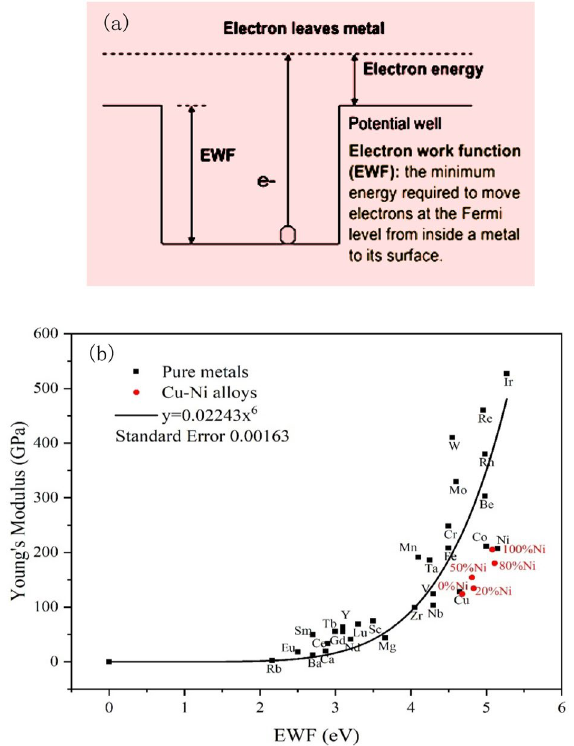
Figure 1. ( a ) Electron work function (EWF) is the minimum energy required to extract electrons at Fermi level from inside a metal to the position just out of its surface; ( b ) Correlation between EWF and Young’ modulus of pure metals (black dots) and Cu-Ni solid solution (red